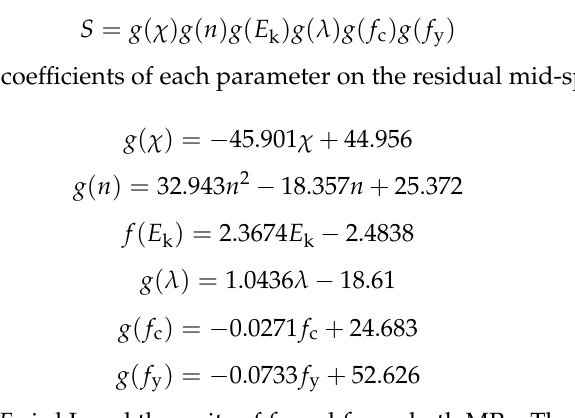
Table 6. Parameter range of formula.